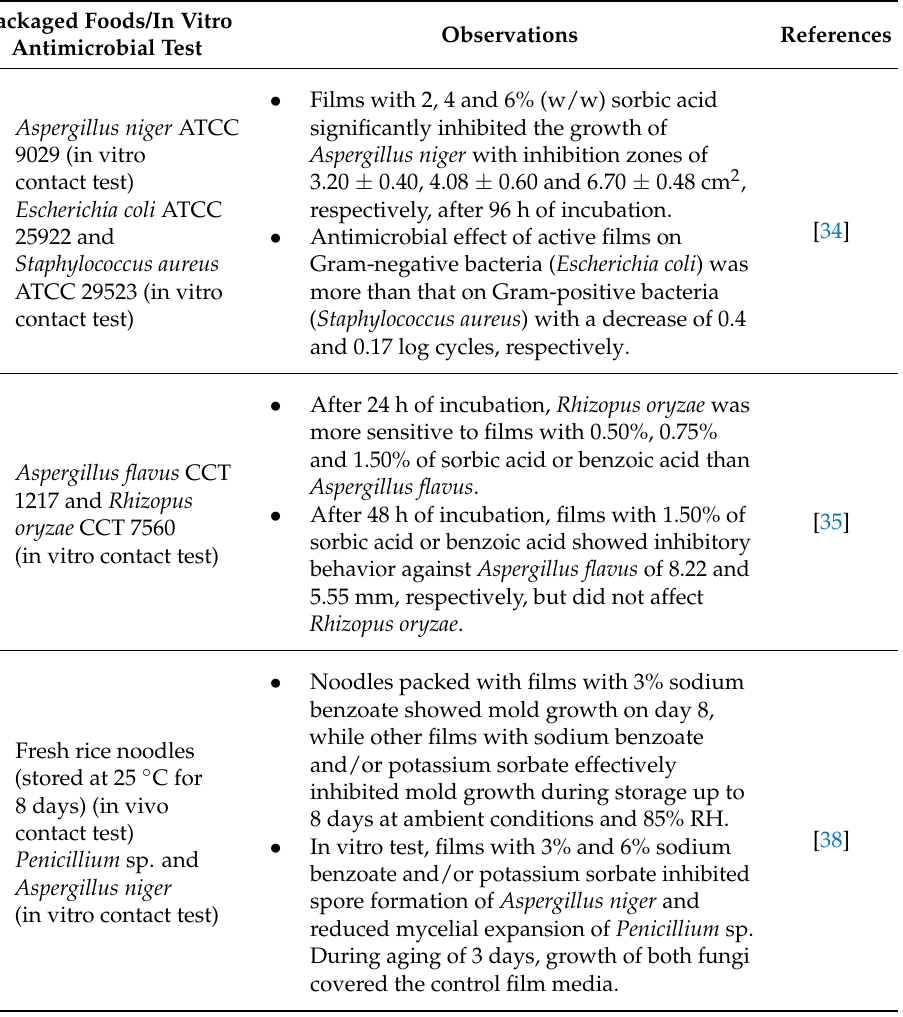
Table 1. Investigations on the development of active antifungal packaging during the last five